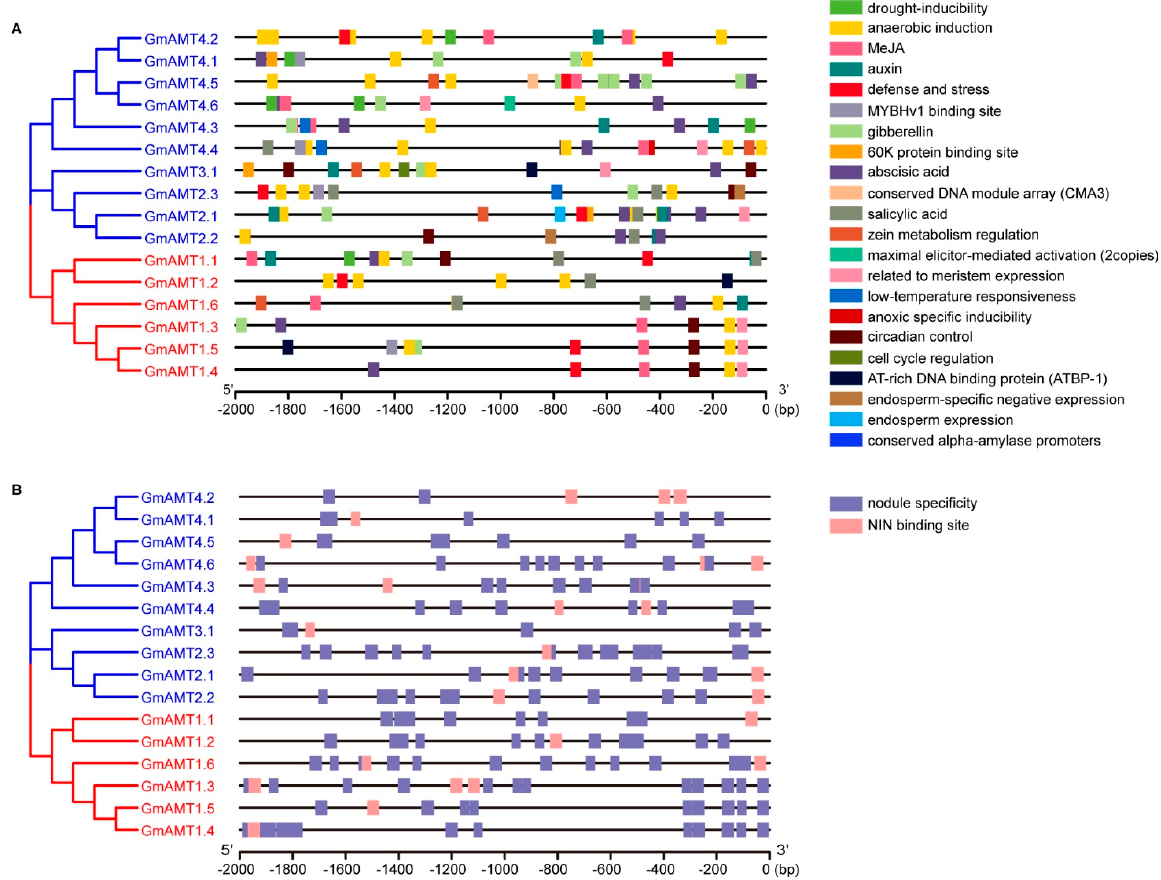
Figure 5. Cis -element analysis of GmAMT promoters. Sequences 2 kb upstream of the transcription initiation site were downloaded from Phytozome and used to analyze the cis -elements. ( A ) The cis -acting elements of 16 AMT promoters in soybean were analyzed by PlantCARE website. ( B ) Cis -acting element analysis of nodule specificity and NIN-binding sites in GmAMT promoters. Cis -acting elements with similar regulatory functions are indicated by the same color.